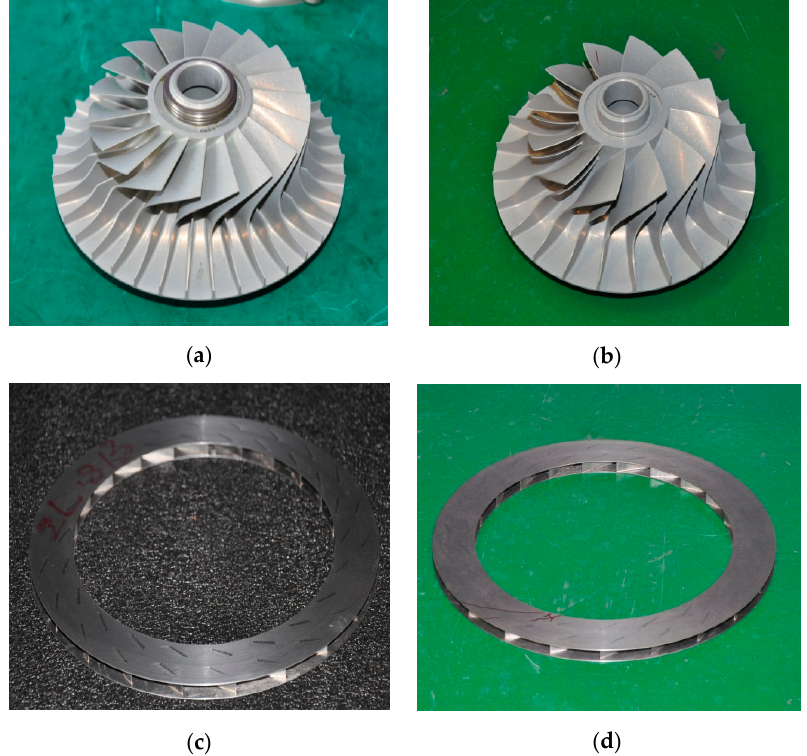
Figure 18. Test parts: ( a ) baseline impeller; ( b ) optimized impeller. ( c ) baseline radial diffuser; ( d ) optimized radial diffuser.